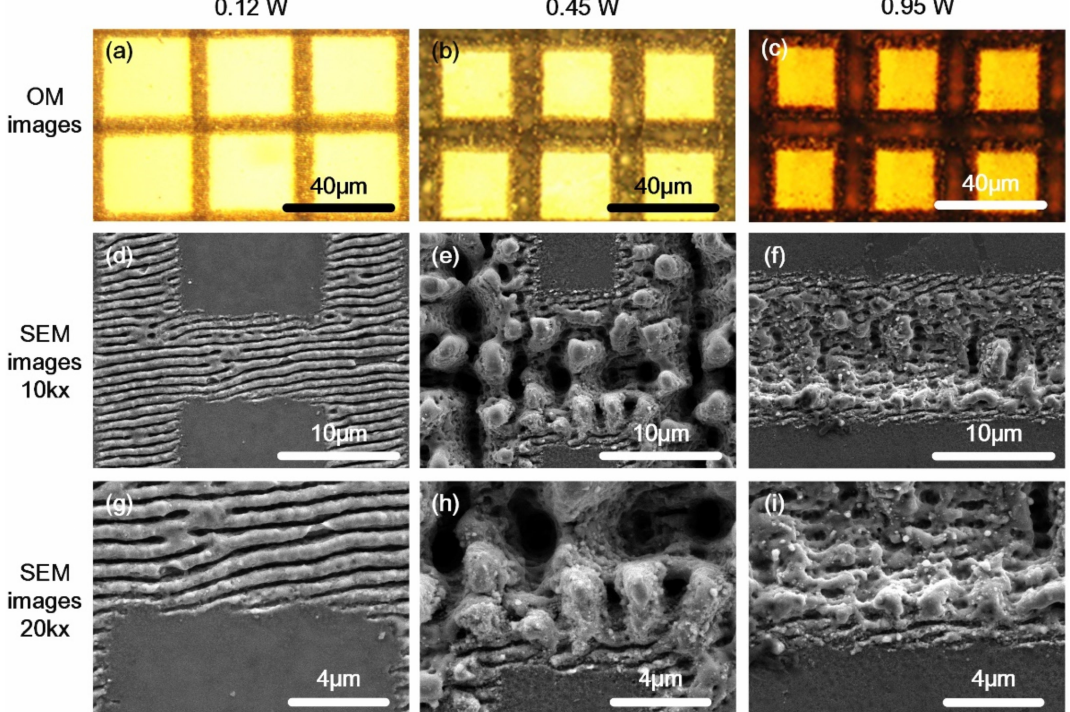
Figure 2. OM and SEM images of Si irradiated by a femtosecond laser at different laser powers. ( a – c ) OM images of a silicon wafer irradiated by a femtosecond laser at the scanning interval of 40 µ m and the laser power of 0.12, 0.45, and 0.95 W, respectively. ( d – f ) 10kx SEM images of a silicon wafer irradiated by a femtosecond laser at the scanning interval of 40 µ m and the laser power of 0.12, 0.45, and 0.95 W, respectively. ( g – i ) 20kx SEM images of a silicon wafer irradiated by a femtosecond laser at the scanning interval of 40 µ m and the laser power of 0.12, 0.45, and 0.95 W,